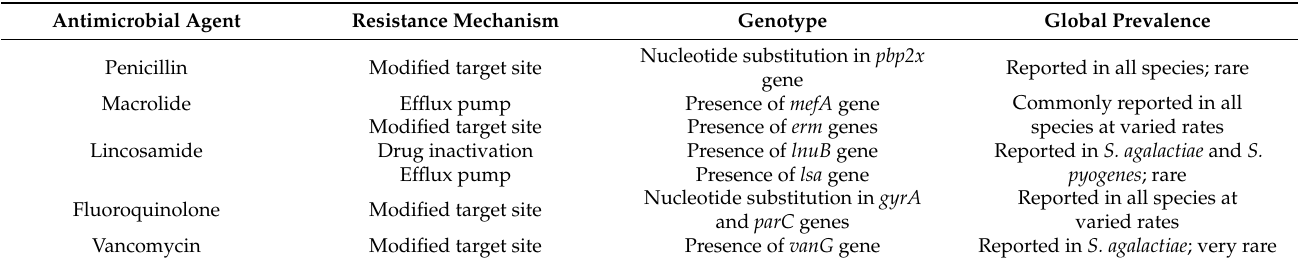
Table 1. Summary of relevant resistance mechanisms to antimicrobial agents recommended to the beta-hemolytic strepto- cocci species addressed in this review.